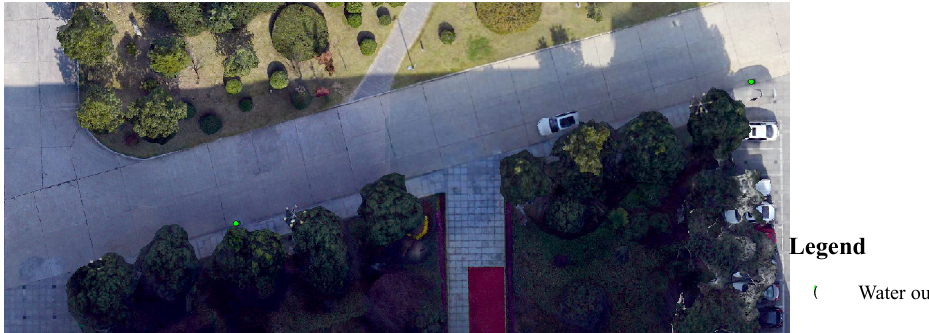
Figure 9. Distribution of water outlets in the study area.